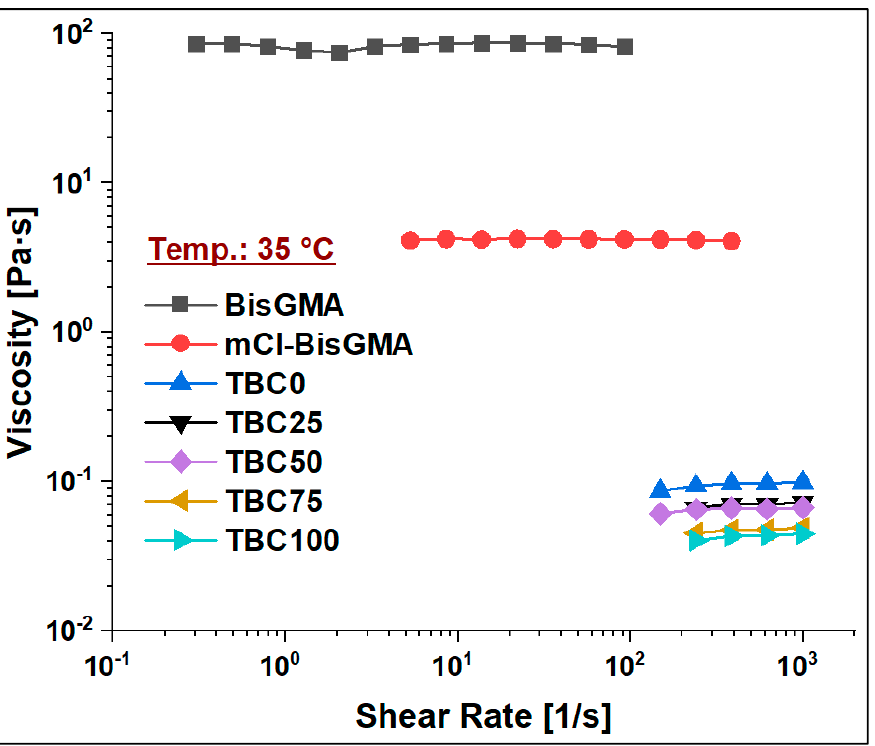
Figure 8. Viscosity curves of BisGMA, mCl-BisGMA, TEGDMA, and resin mixtures TBC0–TBC100 at 25 °C.